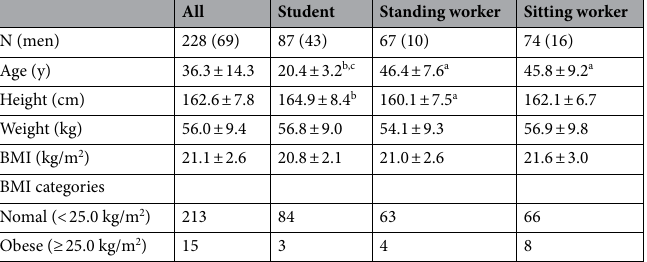
height of the standing worker group was significantly lower than that of the student group. There were no sig- nificant differences in body weight and BMI between the groups (Table 1). The student group had a significantly shorter wearing time than the standing worker and sitting worker groups (753.5 ± 72.5 min/day, 789.9 ± 79.4 min/ day, and 791.7 ± 92.1 min/day, respectively; p = 0.014 and p = 0.031, respectively). Regarding step counts, the student group was significantly smaller than the standing worker group ( p = 0.015) (Fig. 5A). Regarding the PA performance time, the student group had a significantly longer SB performance time ( p < 0.001) and significantly shorter LPA, MPA, and MVPA performance times than the standing worker group ( p < 0.001, p < 0.001, and